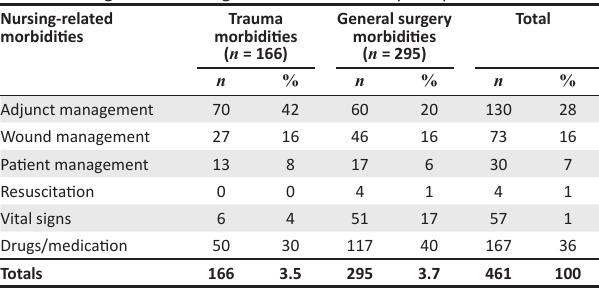
TABLE 3: Categories of nursing-related morbidities by discipline. Nursing-related morbidities